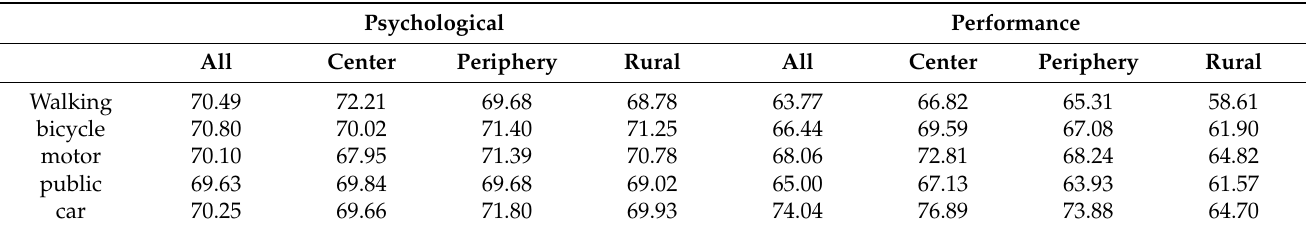
Table 2. Respondents’ well-being by a different commute